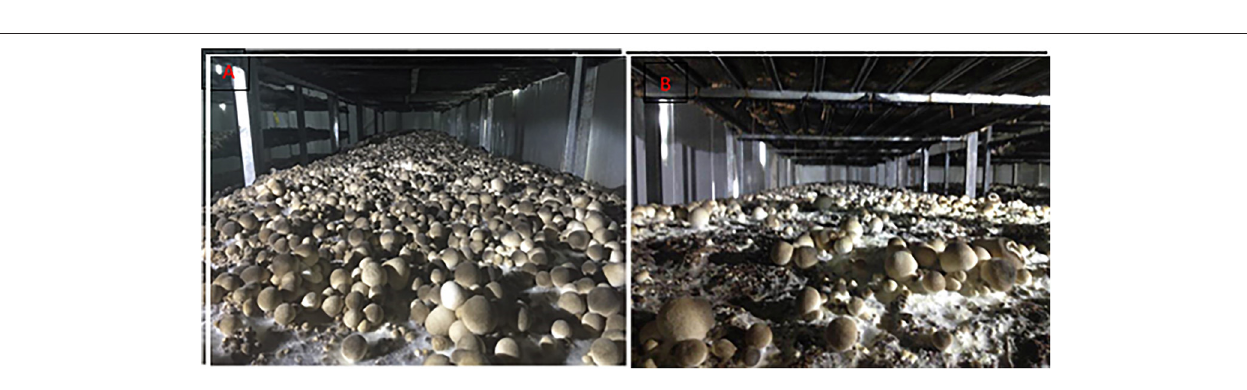
substrate mixing stage increased the yield by 96.74% ( p < 0.05). The production phenotype of the primordium stage and the egg stage in the farm are shown in Figure 3 . Spraying at